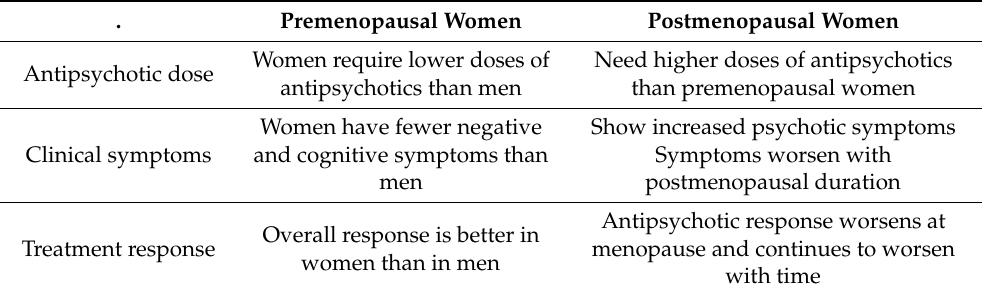
Table 1. Effects of menopause on clinical outcomes in women with schizophrenia.